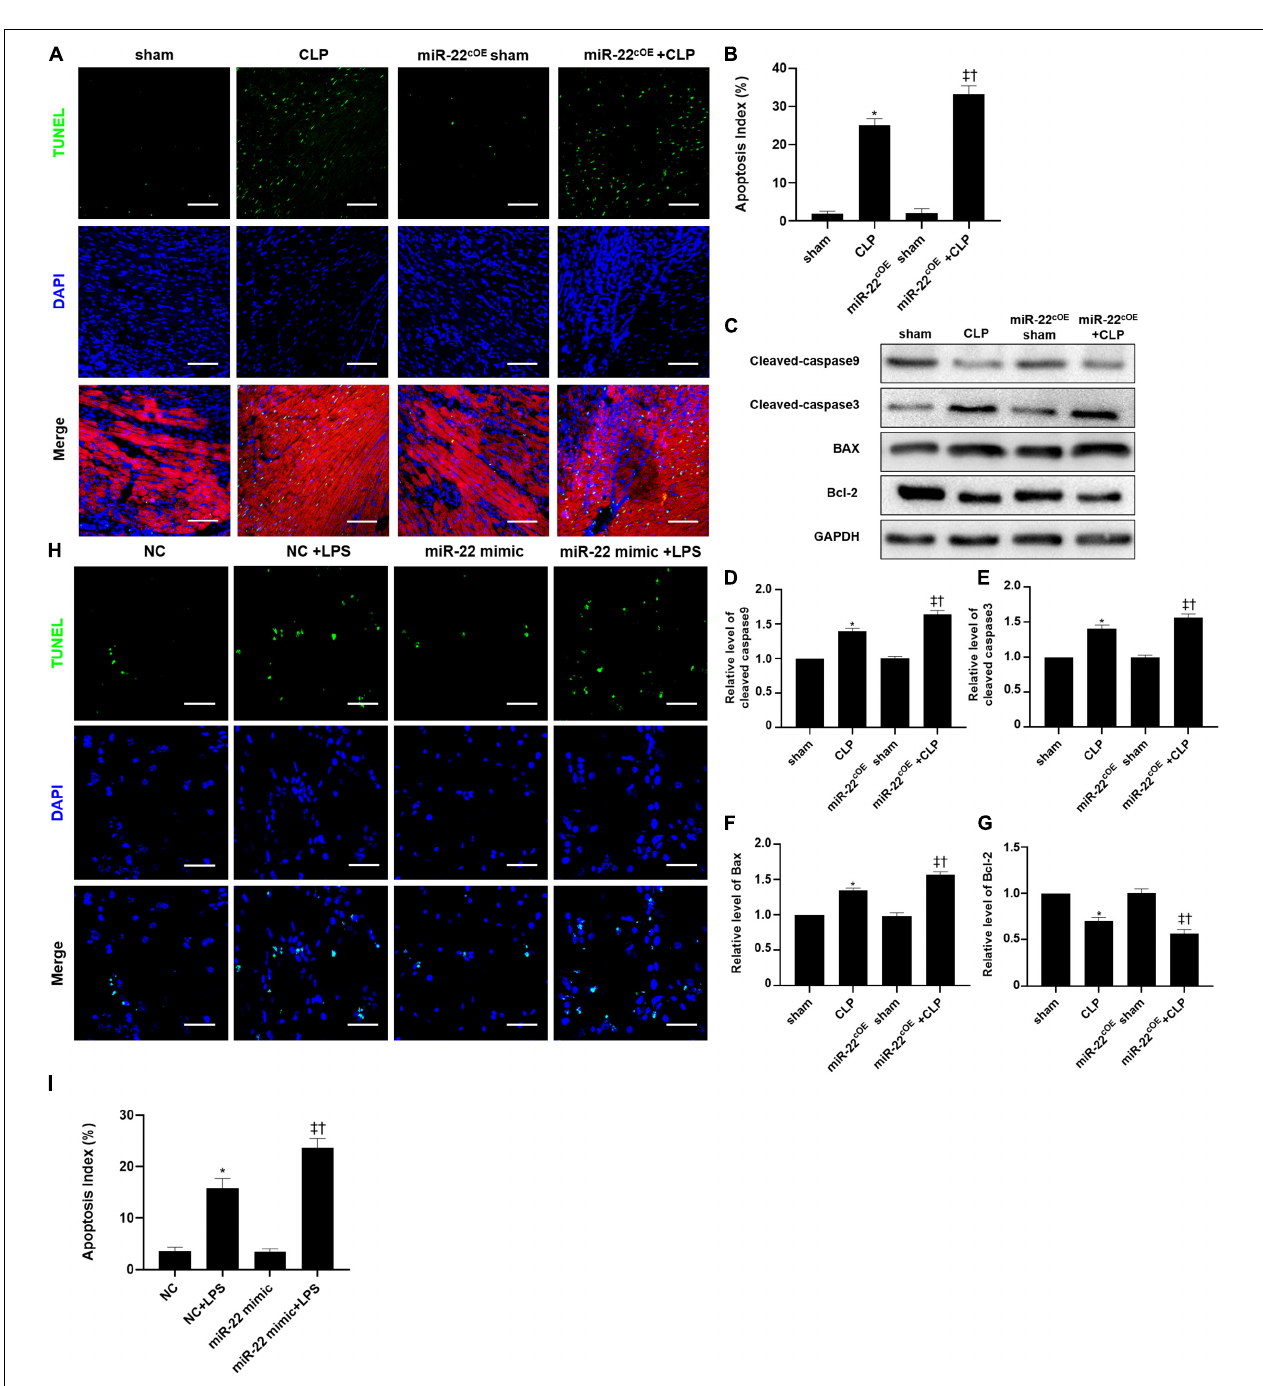
FIGURE 7 | (A) Representative images of TUNEL staining (myocardium); Scale bar = 50 µ m. (B) Percentage of TUNEL-positive nuclei. (C) Representative Western blots. (D) Relative cleaved-caspase9 protein level ratio. (E) Relative cleaved-caspase3 protein level ratio. (F) Relative BAX protein level ratio. (G) Relative Bcl-2 protein level ratio; Data were expressed as mean ± SEM. ∗ P < 0.05 vs. sham group; ‡ P < 0.05 vs. CLP group; † P < 0.05 vs. miR-22 cOE sham group. (H) Representative TUNEL staining images; Scale bar = 50 µ m. (I) Percentage of TUNEL-positive nuclei. ∗ P < 0.05 vs. NC group; ‡ P < 0.05 vs. NC + LPS group; † P < 0.05 vs. miR-22 mimic group. All the experiments were repeated three